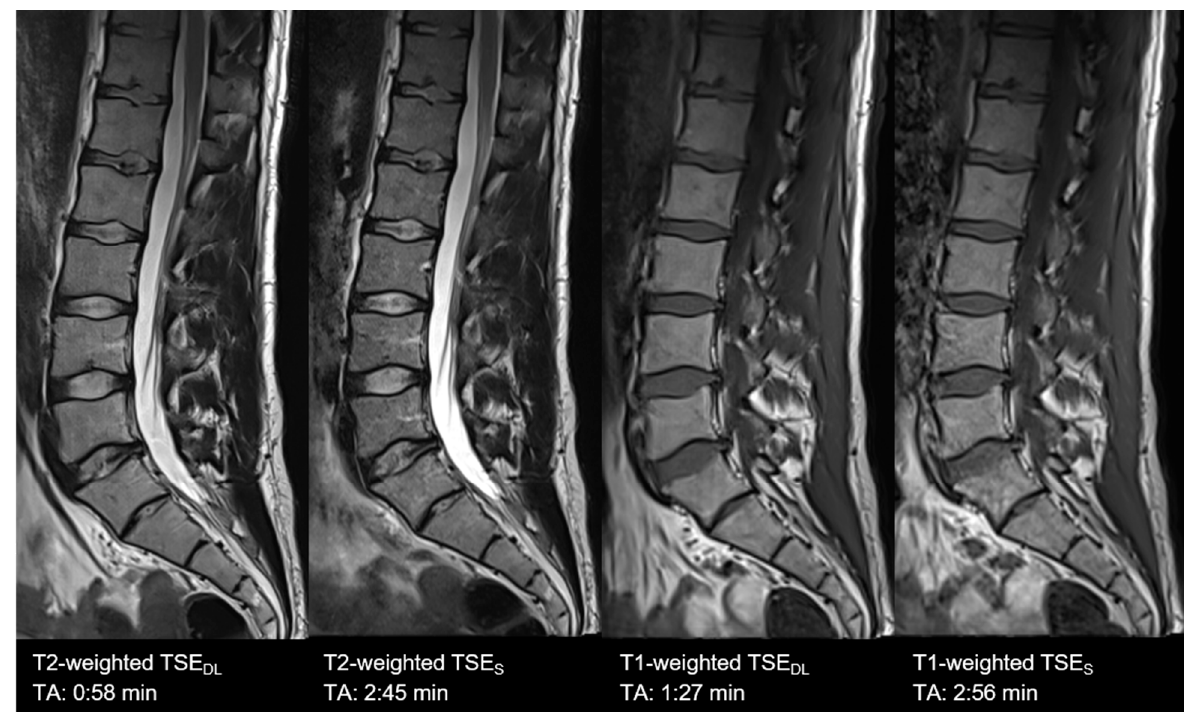
Figure 5. Example of a Deep Learning and standard T1- ( right ) and T2-weighted ( left ) turbo spin echo image of the lumbar spine in sagittal orientation. Note that TSE DL show lower extents of noise both in T1- and T2-weighted imaging. Nonetheless, some small structures, such as small bone canals, disappear; there is no impact on the delineation and assessment of relevant anatomical structures in both TSE S and TSE DL .